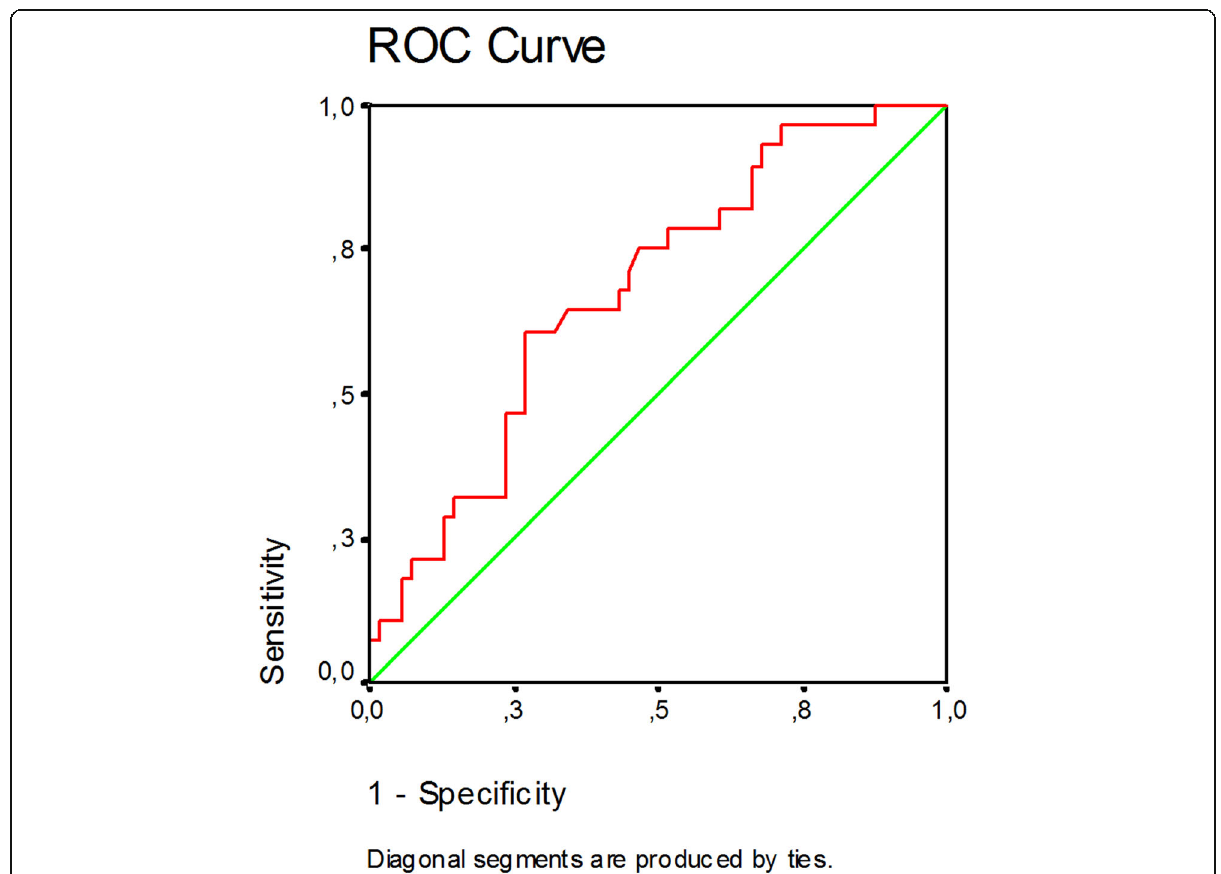
Fig. 2 Receiver operating characteristic curve to calculate the best MBD value for predicting clinical